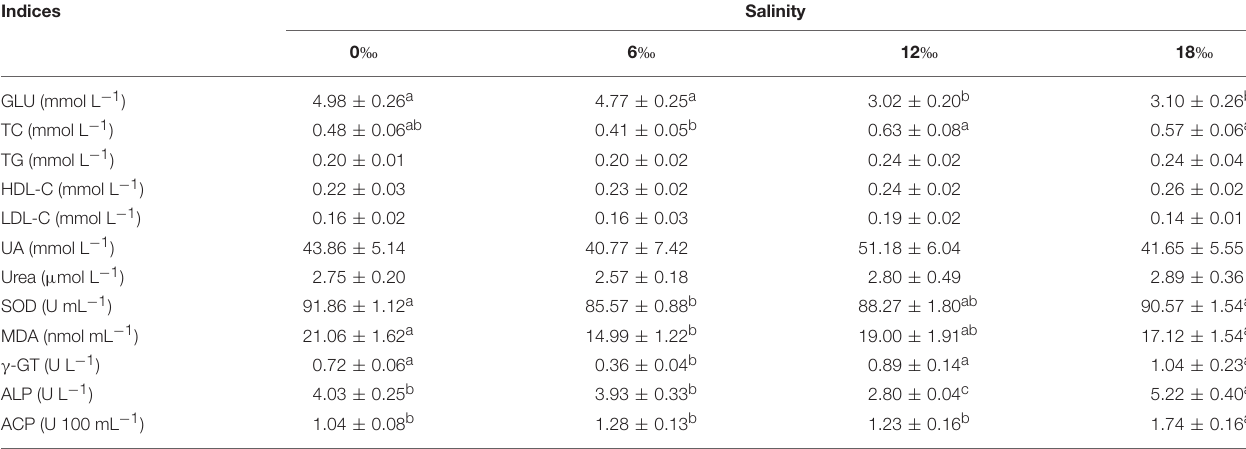
TABLE 5 | Hemolymph metabolism indices of female E. sinensis subjected to different salinities for 40 days. Indices